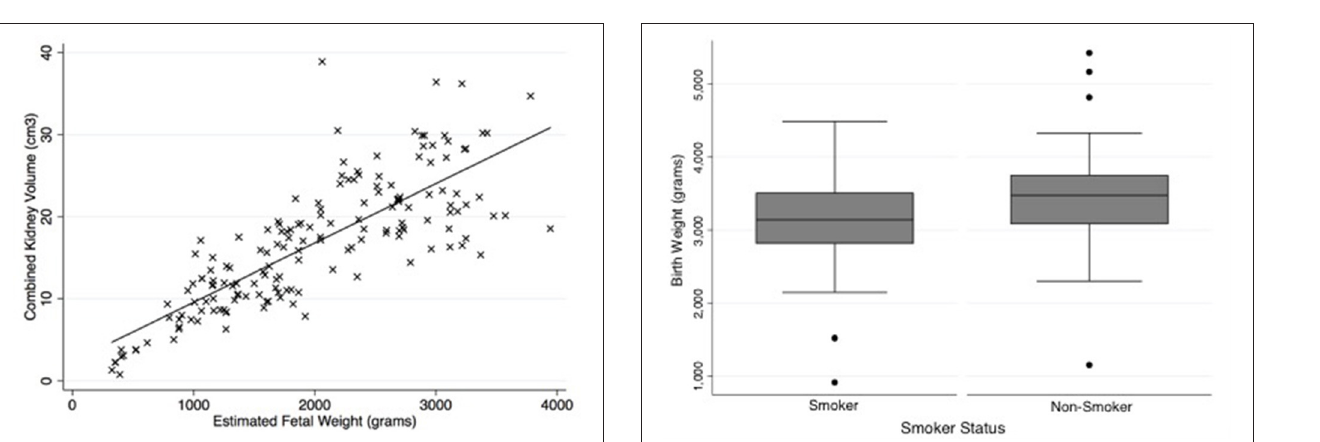
FIGURE 2 | There was a significant correlation between estimated fetal weight and combined kidney volume (rho = 0.82, p < 0.001). Equation is y = 2.32 + 0.007 (estimated fetal weight). Number of observations = 164.